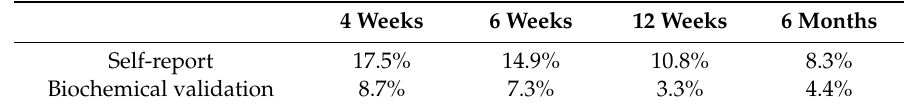
Table 3. Smoking abstinence prevalence rates at 4 weeks, 6 weeks, 12 weeks, and 6 months, as assessed by self-report and biochemical